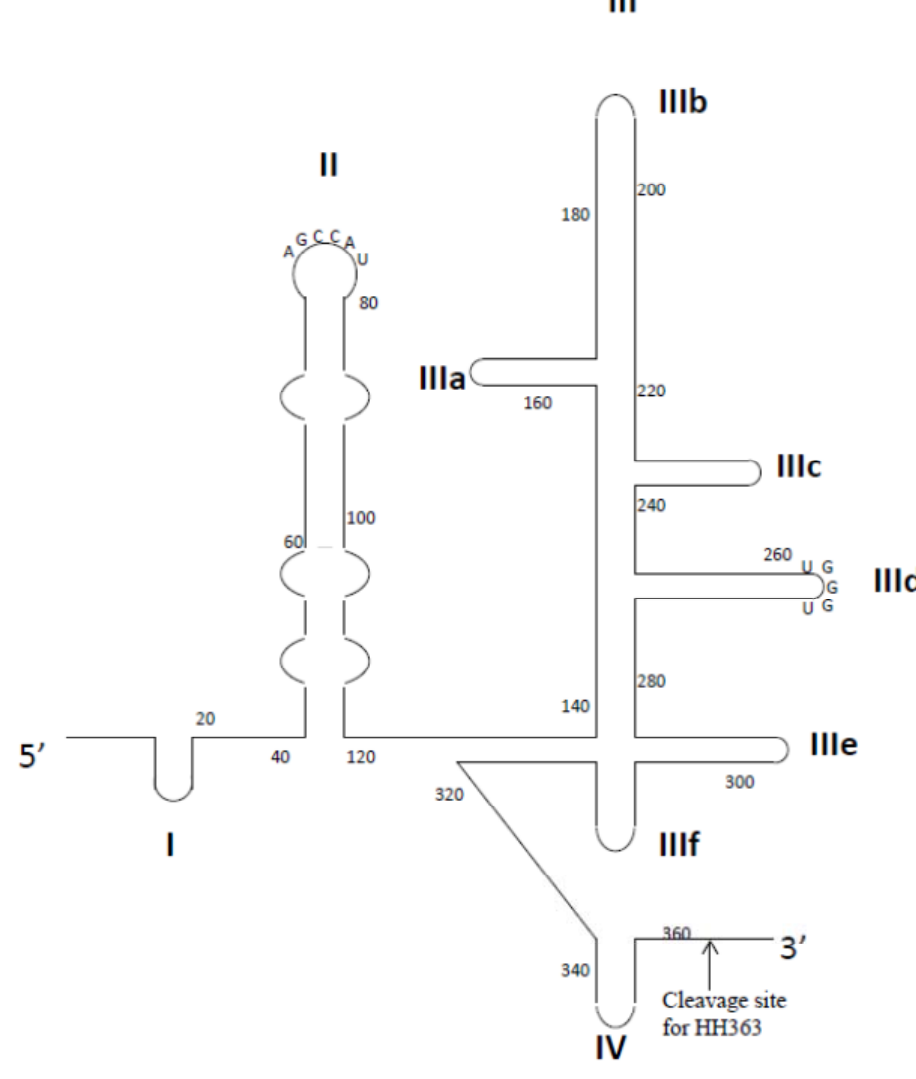
Figure 3. Representation of the secondary structure of HCV IRES. Structural domains are shown as I–IV. The HH363 cleavage site is indicated by an